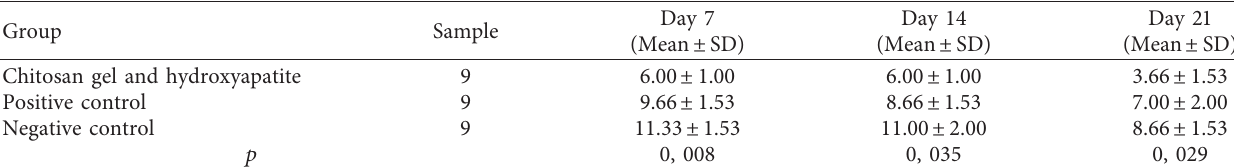
Figure 3: Expression of BMP-2 with 1000 times magnification, (a) expression of BMP-2 on the 7th day in the treatment group (a combination of chitosan gel and hydroxyapatite of crab shells), (b) expression of BMP-2 on the 14th day in the treatment group (combination of chitosan gel and hydroxyapatite of crab shells), (c) expression of BMP-2 day 21 in the treatment group (combination of chitosan gel and hydroxyapatite of crab shells), (d) expression of BMP-2 on day 7 in the control group positive (BATAN Hydroxyapatite), (e) 14th-day BMP-2 expression in the positive control group (BATAN Hydroxyapatite), (f) 21st day BMP-2 expression in the positive control group (BATAN Hydroxyapatite), (g) BMP-expression 2 days seven negative control group (placebo gel), (h) BMP-2 expression on 14days negative control group (placebo gel), and (i) BMP-2 expression on 21 days negative control group (placebo gel). Table 2: Descriptive statistics showing results of IL-1